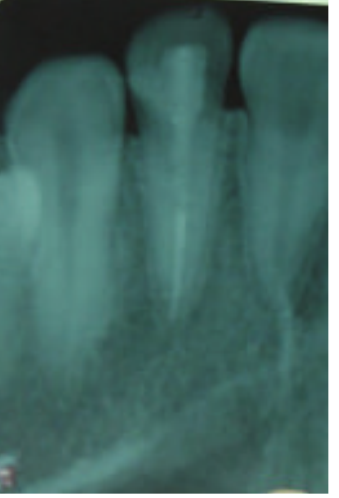
Figure 11: Radiographic appearance after two and half